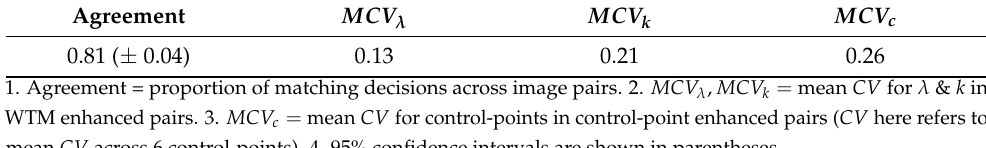
Table 4. Inter-observer variability across image pairs. Agreement MCV λ MCV k MCV c 0.81 ( ± 0.04) 0.13 0.21